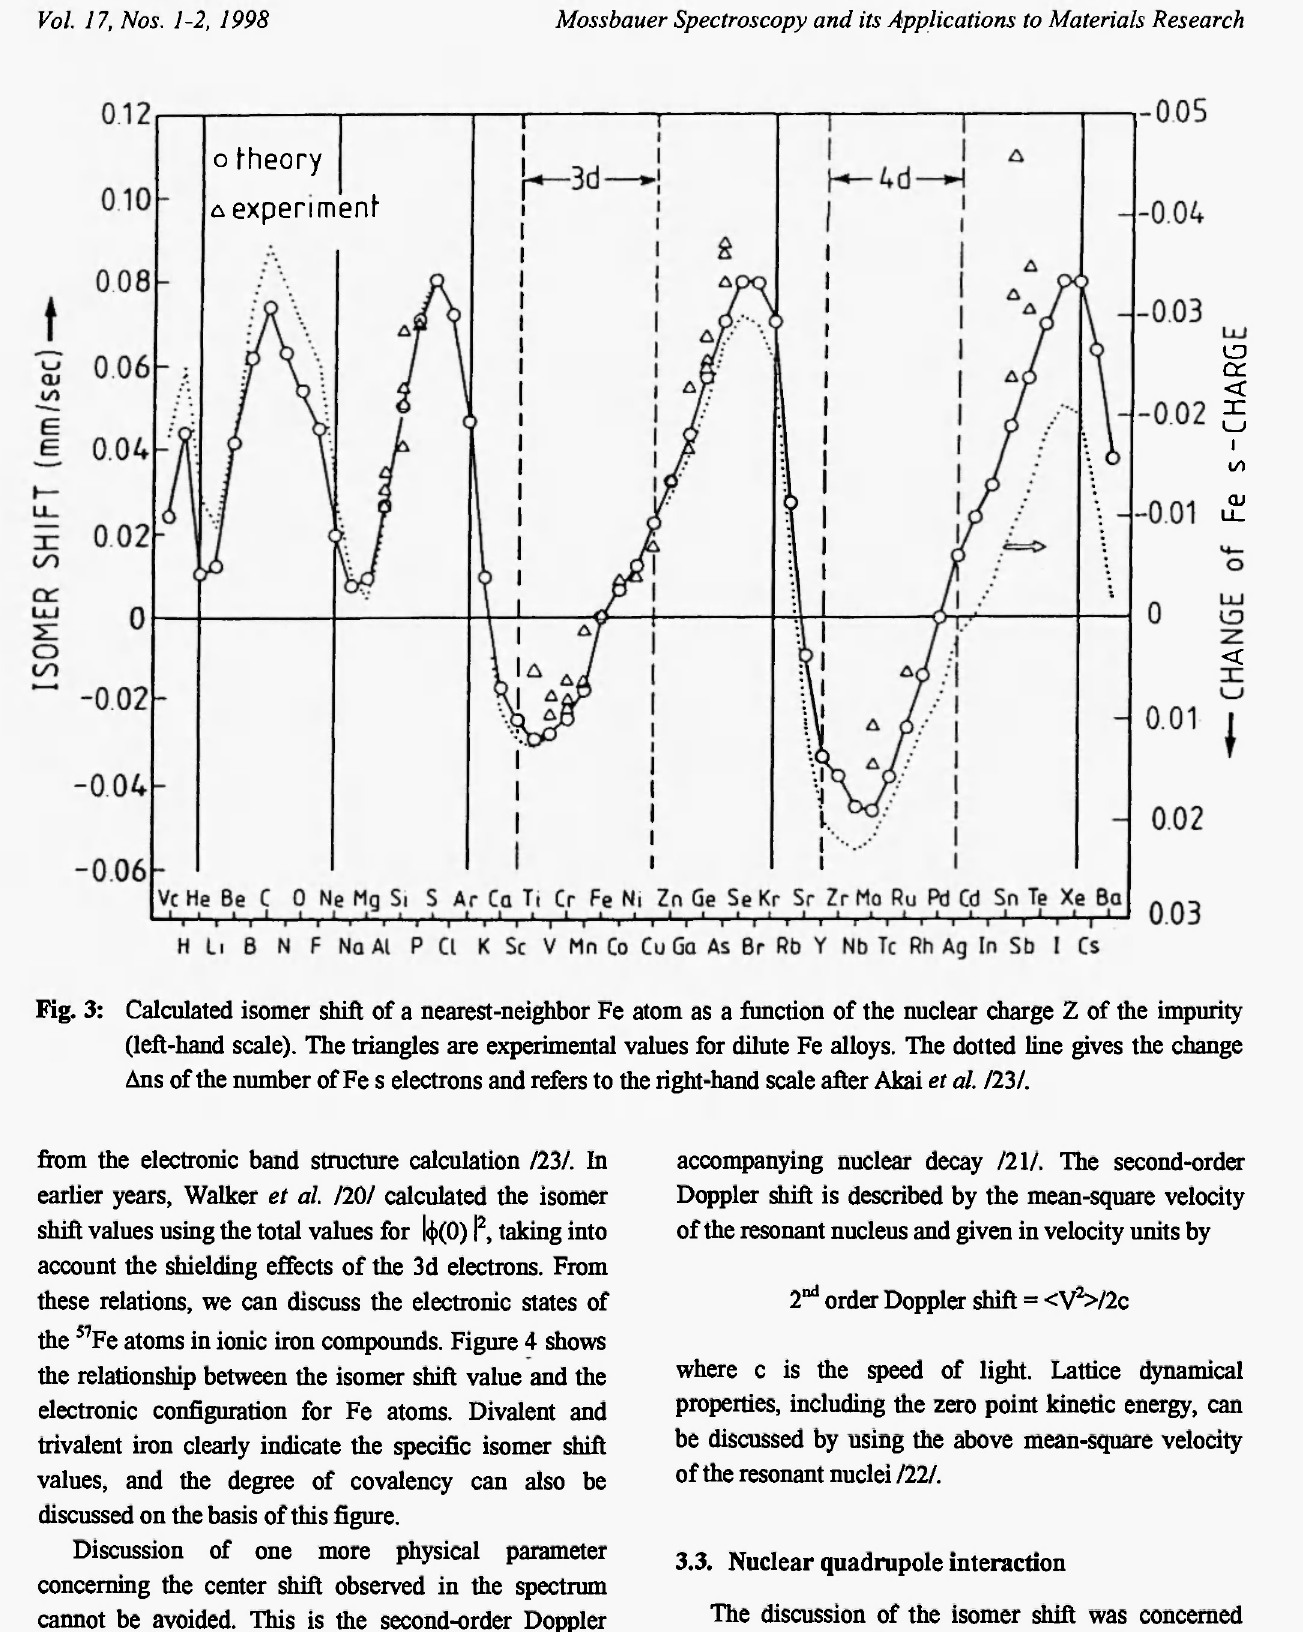
Fig. 3: Calculated isomer shift of a nearest-neighbor Fe atom as a function of the nuclear charge Ζ of the impurity (left-hand scale). The triangles are experimental values for dilute Fe alloys. The dotted line gives the change Ans of the number of Fe s electrons and refers to the right-hand scale after Akai et al. 1221. from the electronic band structure calculation 1221.